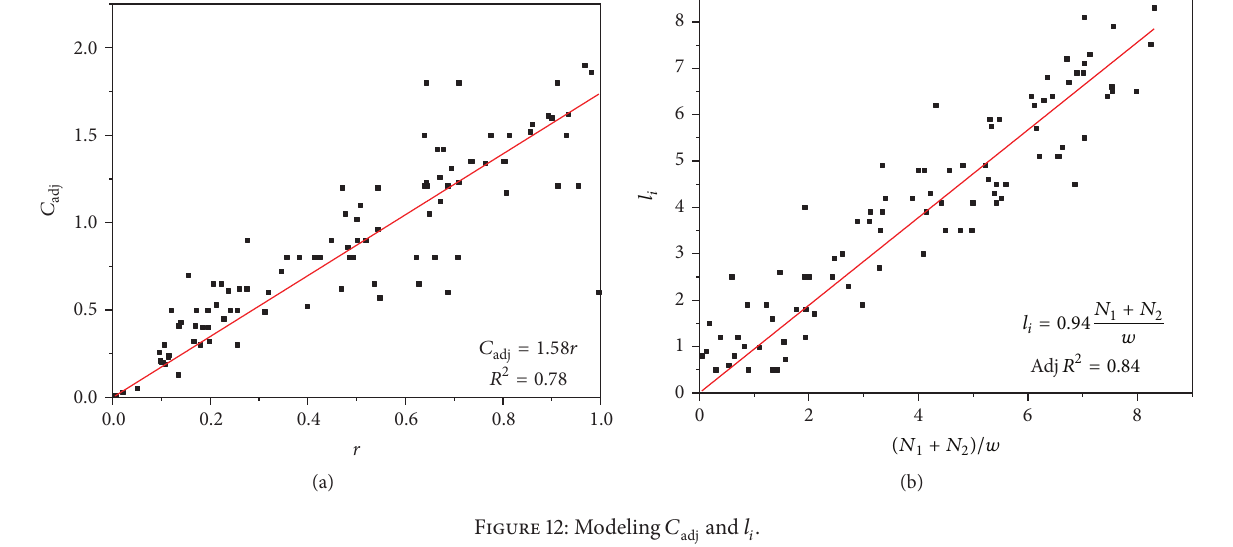
Figure 12: Modeling 𝐶 adj and 𝑙 𝑖 .